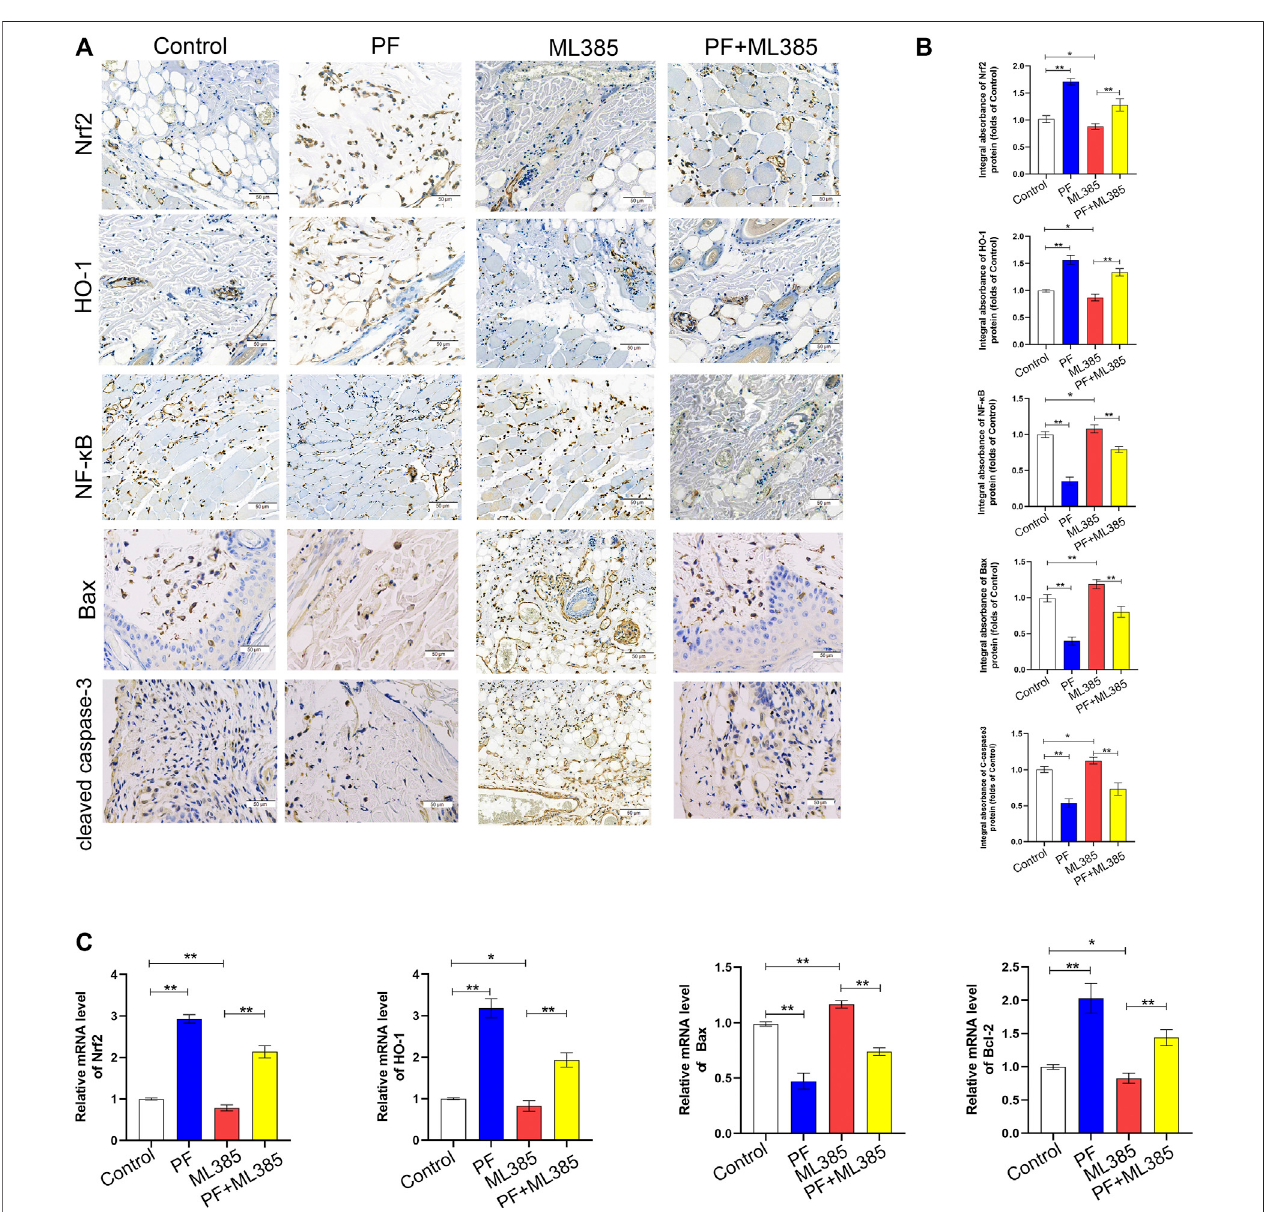
FIGURE 8 | Paeoni fl orin (PF)-mediated cytoprotection involved the Nrf2 pathway in vivo . (A) IHC of proteins Nrf2, HO-1, NF- κ B, Bax and cleaved caspase-3 in ischemic tissues(original magni fi cation, 200 × ; scan bar, 50 μ m). (B) Quanti fi cation of integral absorbanceof Nrf2, HO-1, NF- κ B, Bax and cleaved caspase-3 in IHC. (C) ThecontentsofNrf2,HO-1,Bax,andBcl-2genesintheskintissueweredetermined byreal-timequantitativePCRandthedatawerenormalizedtoGAPDH.( n (cid:2) 6mice per group). Data: mean ± SD, * p < 0.05 and ** p < 0.01. n (cid:2) 6.